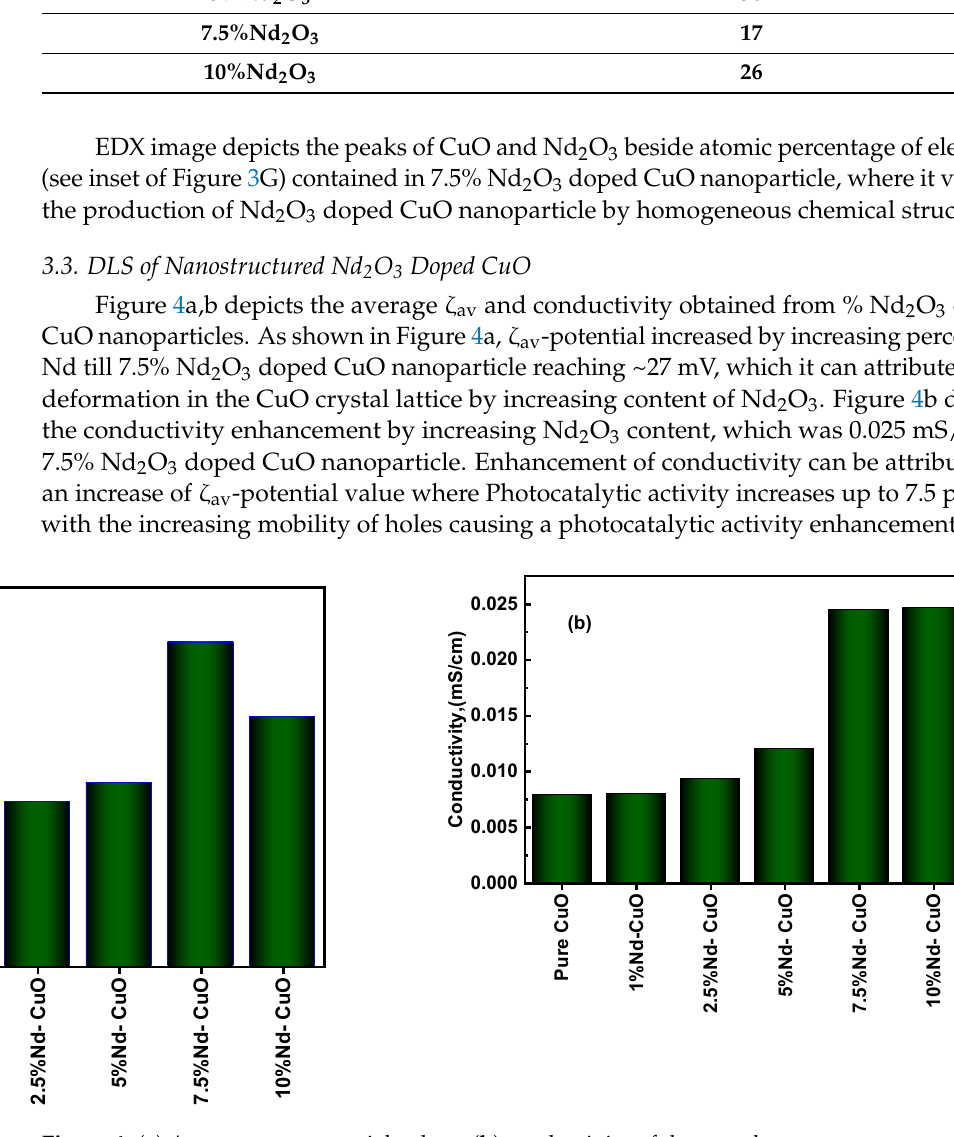
Figure 4. ( a ) Average zeta potential values, ( b ) conductivity of the